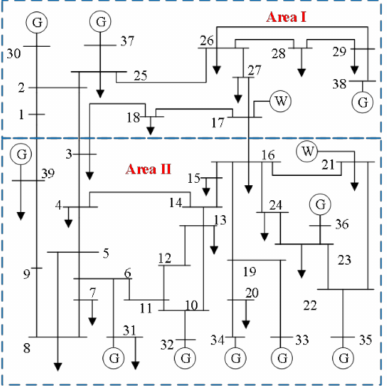
Figure 2. The modified IEEE 39-bus system for case study.